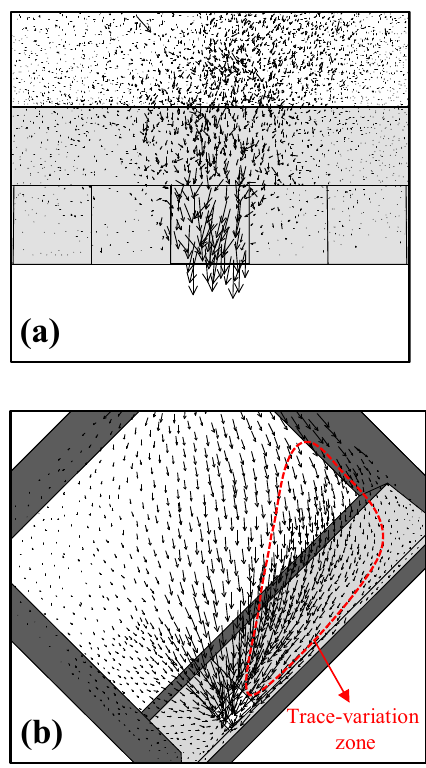
Fig. 7 Distribution of the particle velocity field along the working face: a flat seam; b inclined seam